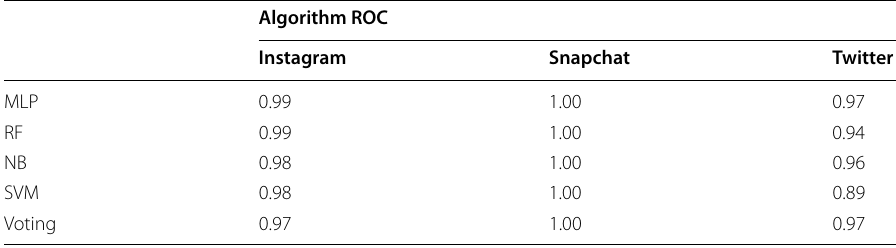
Table 13 ROC values for the best